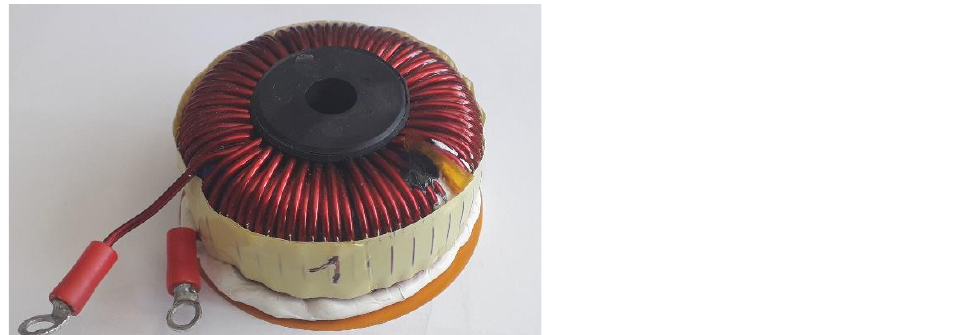
Figure 19. Original alloy core inductor used within optimized PFC converter used for referenced measurements. Figure 18. Principal schematic of PFC converter used for evaluation purposes.